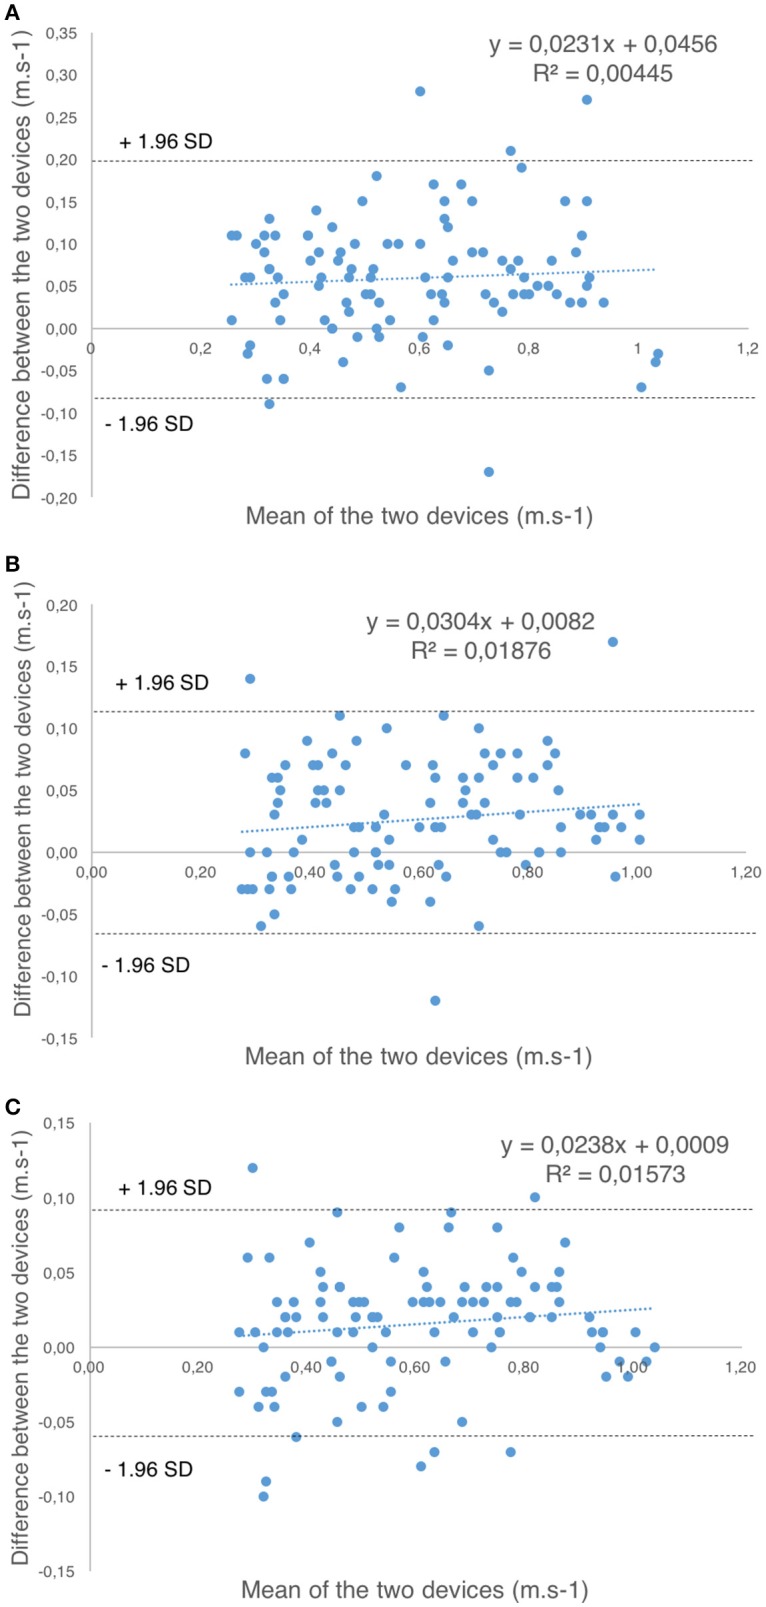
Bland-Altman plots for the measurement of barbell velocity between the linear transducer (LT) and: (A)
Beast sensor (wrist, BW); (B)
Beast sensor (barbell, BB); (C)
PowerLift app for the hip-thrust exercise. The blue dashed line represents the first-order regression line of the data, while the gray dashed lines represents ±1.96 standard deviations (SD).